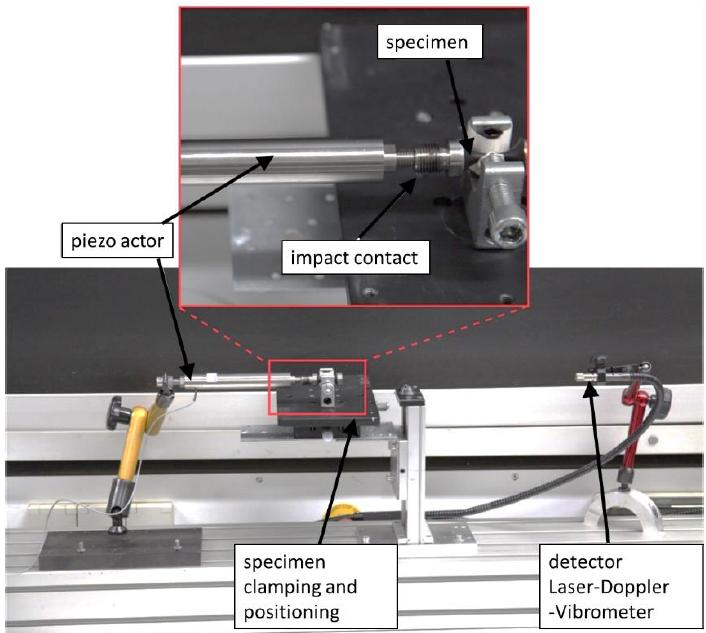
Figure 3. Experimental setup for modal analysis by LDV showing a VHCF-specimen.